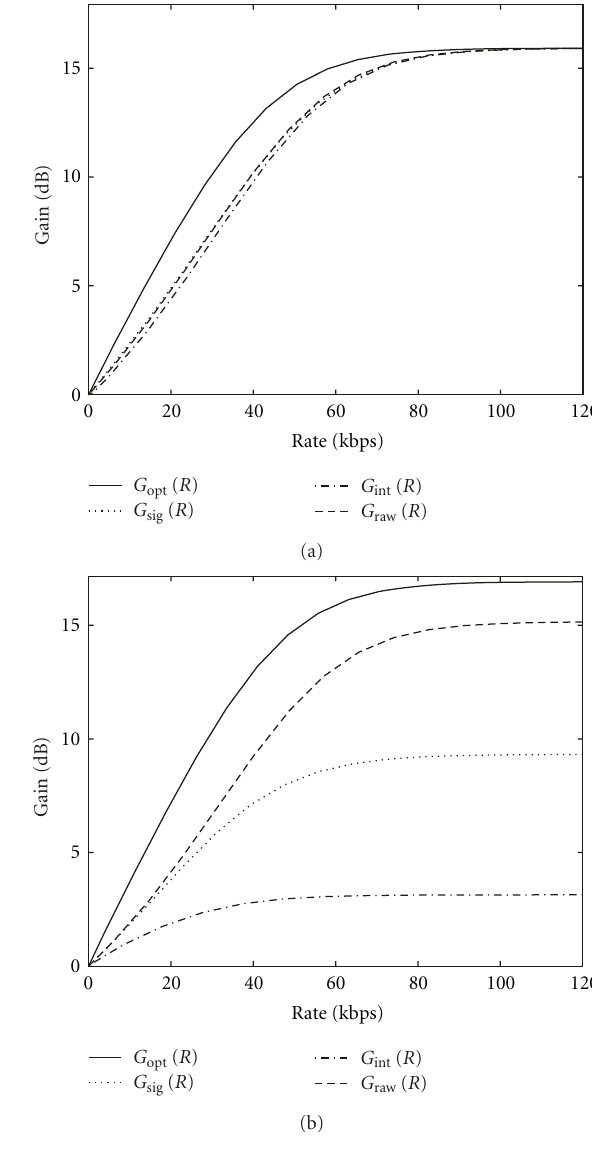
Figure 6: Performance gain for the di ff erent schemes when a desired signal is observed in the presence of uncorrelated noise at 20dB SNR, and an interfering source at 0 dB SIR located at − 30 ◦ . (a) K = 1, (b) K = 2.